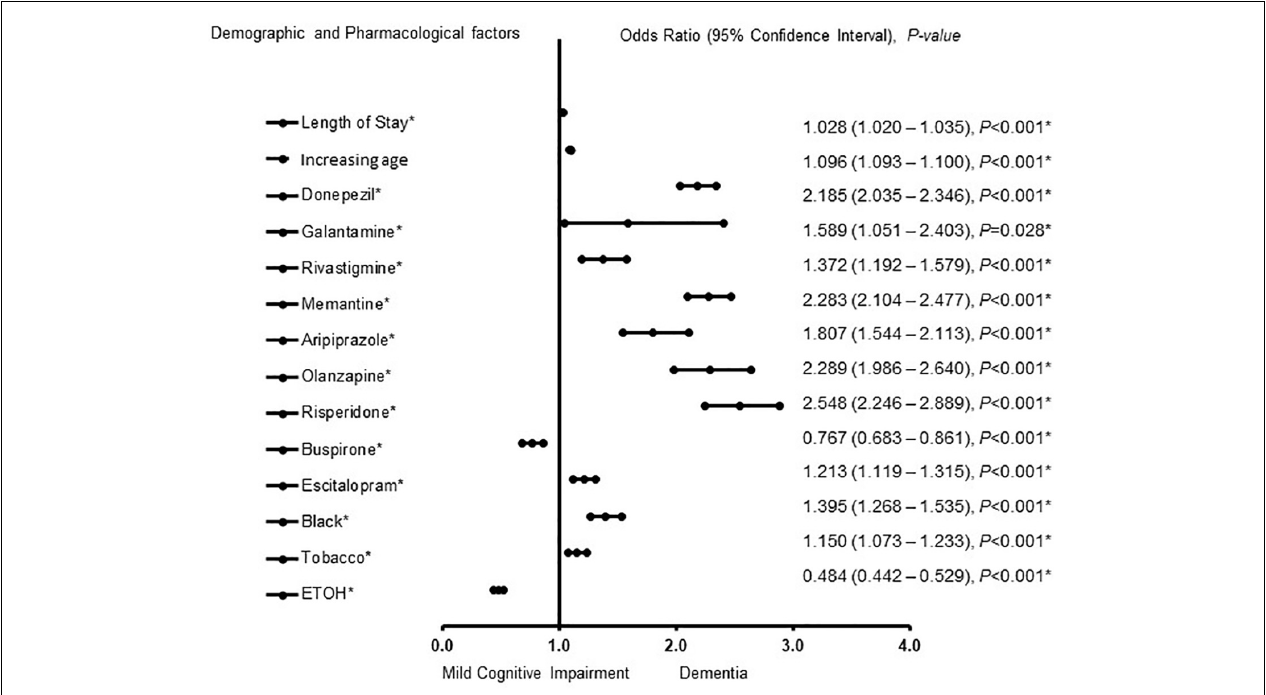
FIGURE 2 | Demographic and pharmacological factors that were associated with mild cognitive impairment and Alzheimer patients with dementia in females. Adjusted OR < 1 denote factors that are associated with mild cognitive impairment while OR > 1 denote factors that are associated with dementia. Hosmer-Lemeshow test ( P < 0.001*), Cox & Snell (R 2 = 0.307). The overall classified percentage of 70.7% was applied to check for fitness of the logistic regression model. *Indicates statistical significance ( P < 0.05) with a 95% confidence